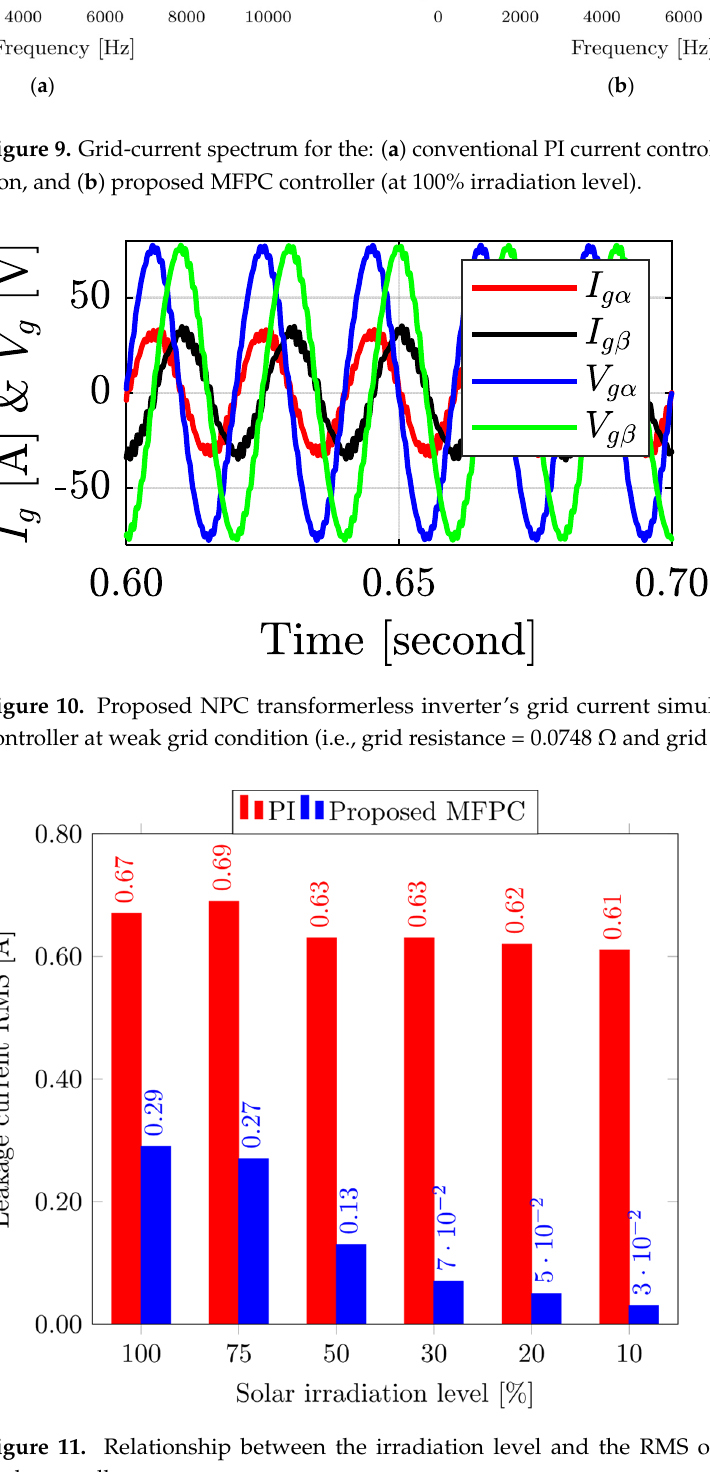
Figure 12. Power loss distribution with the proposed MFPC. Figure 13 depicts how the e ffi ciency of the MFPC and PI controllers varies with the irradiation intensity. The MPC controller has higher e ffi ciency than the PI controller at most irradiation values. Because the two instances use the same hardware, but distinct processors, the inverter switching pa tt ern and harmonics vary. These variations resulted from the MPC controller’s superior switching pa tt erns and reduced overtones compared to other controllers. Therefore, the MPC controller’s low harmonic and tiny switching losses account for its greater e ffi ciency. The change of the grid current THD with the irradiation level is shown in Figure 14. Although the grid current THD has excellent performance for high insolation levels, the THD for low insolation levels <20% is higher than the standards. This is one of the limita- tions of this system and will be a future research point. Therefore, the current error mini- mization procedure that takes place when the MFPC controller is applied may be utilized to describe the outcome in this paper.